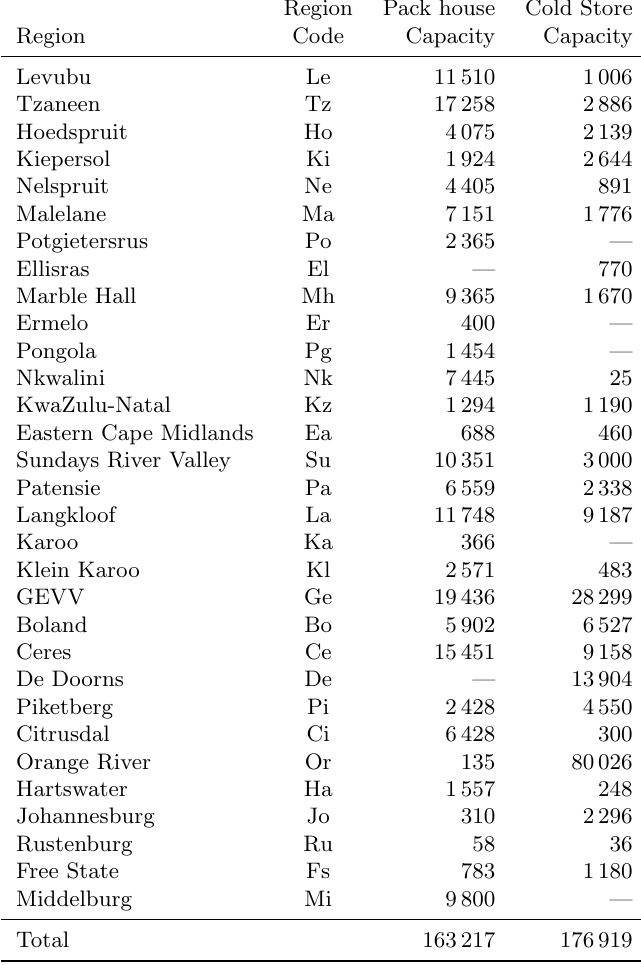
Table 2: Capacities of pack houses and cold stores (measured in pallets processed per week) in each of the 31 the fruit production regions of South Africa. (GEVV represents the area around the Western Cape towns of Grabouw, Elgin, Villiersdorp and Vyeboom.) Note that the cold stores listed for the Johannesburg region include those at the airport. The cold stores in or near ports are